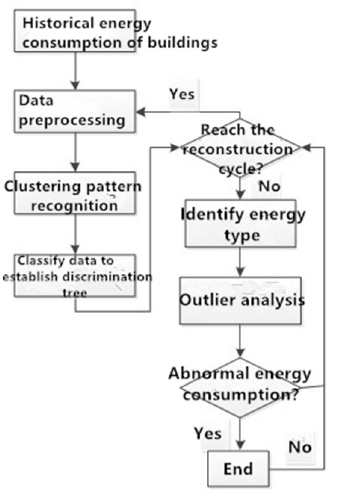
Figure 3. Flow chart of building energy consumption